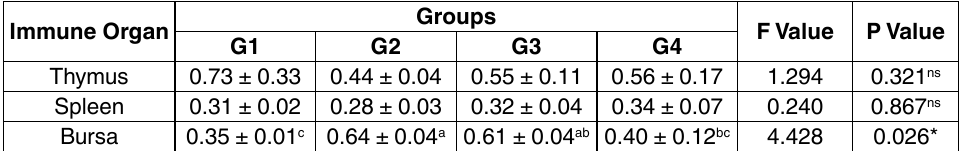
Table 2. Yield of Immune organs # (%) in birds supplemented with graded levels of C. vulgaris extract Immune